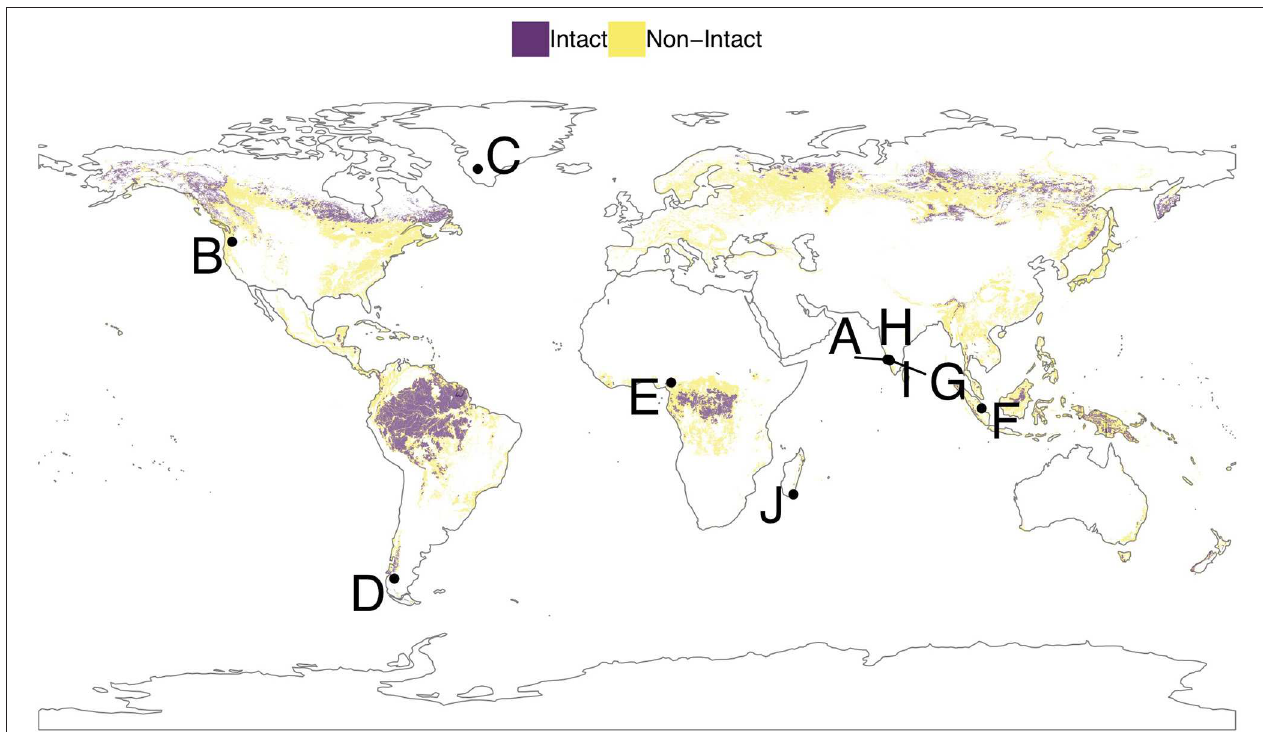
FIGURE 3 | Intact forest landscape (IFL) and non-intact forest pixels with locations of selected paleoecological studies illustrating the range of forest responses to past disturbance. Table 1 lists the details of each study.